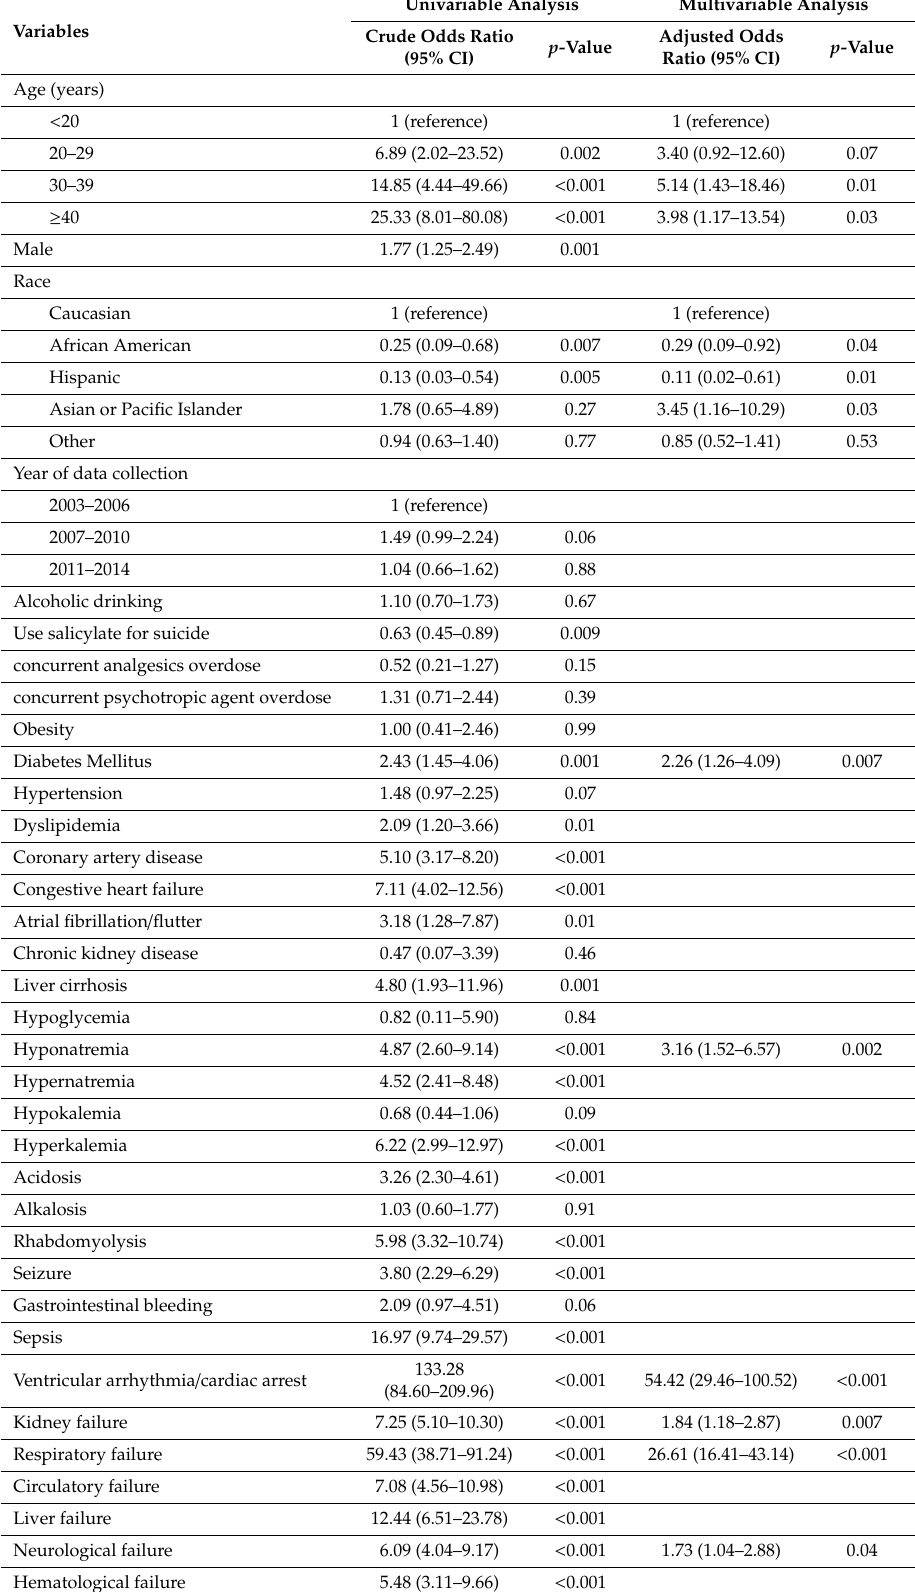
Table 3. Factors associated with in-hospital mortality for salicylate